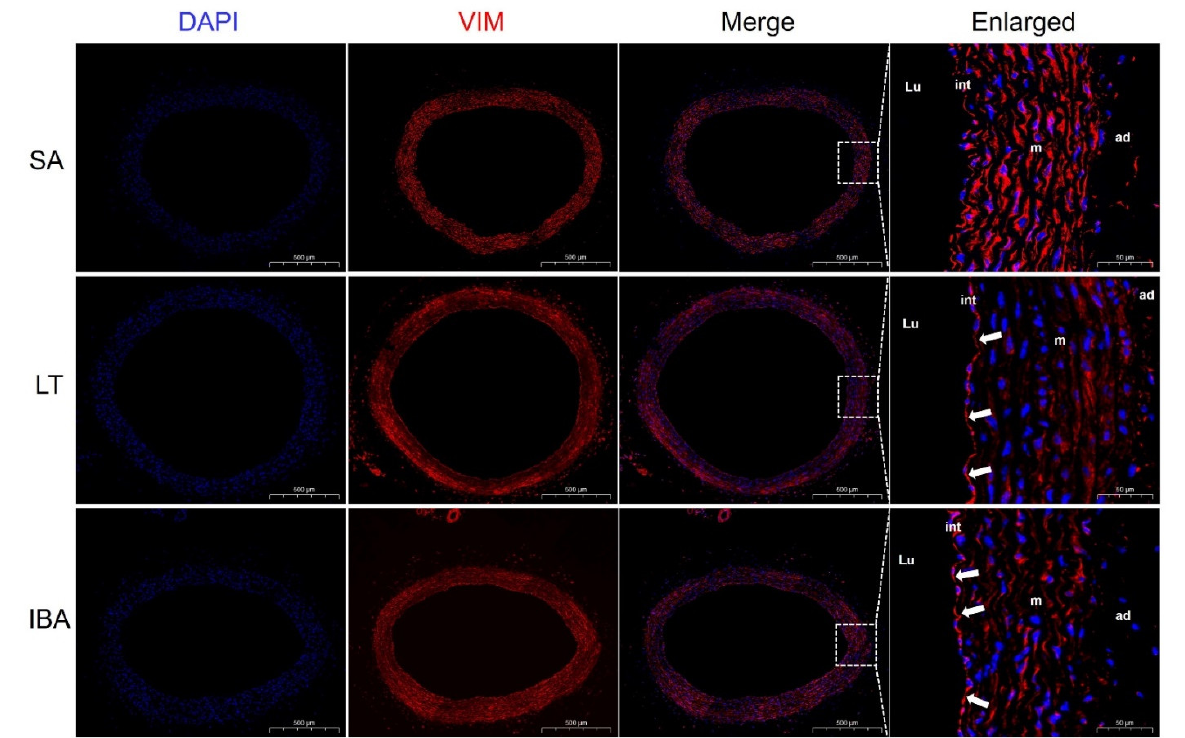
Figure 7. Immunofluorescence staining of VIM in thoracic aorta. DAPI (blue) labels the nucleus, and CY3 (red) labels VIM. The scale in left column = 500 µ m. The scale in right column = 50 µ m. Changes in endothelial localization are shown by white arrows. SA: summer active, LT: late torpor, IBA: interbout arousal, Lu: lumen, int: intima, m: media, ad: adventitia.